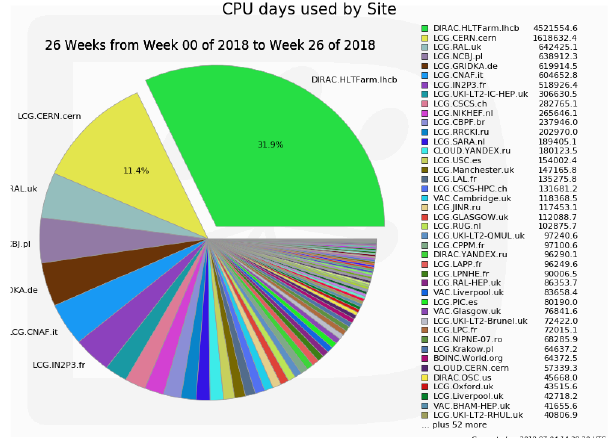
Figure 5. HLT farm activity during data taking start-up period.